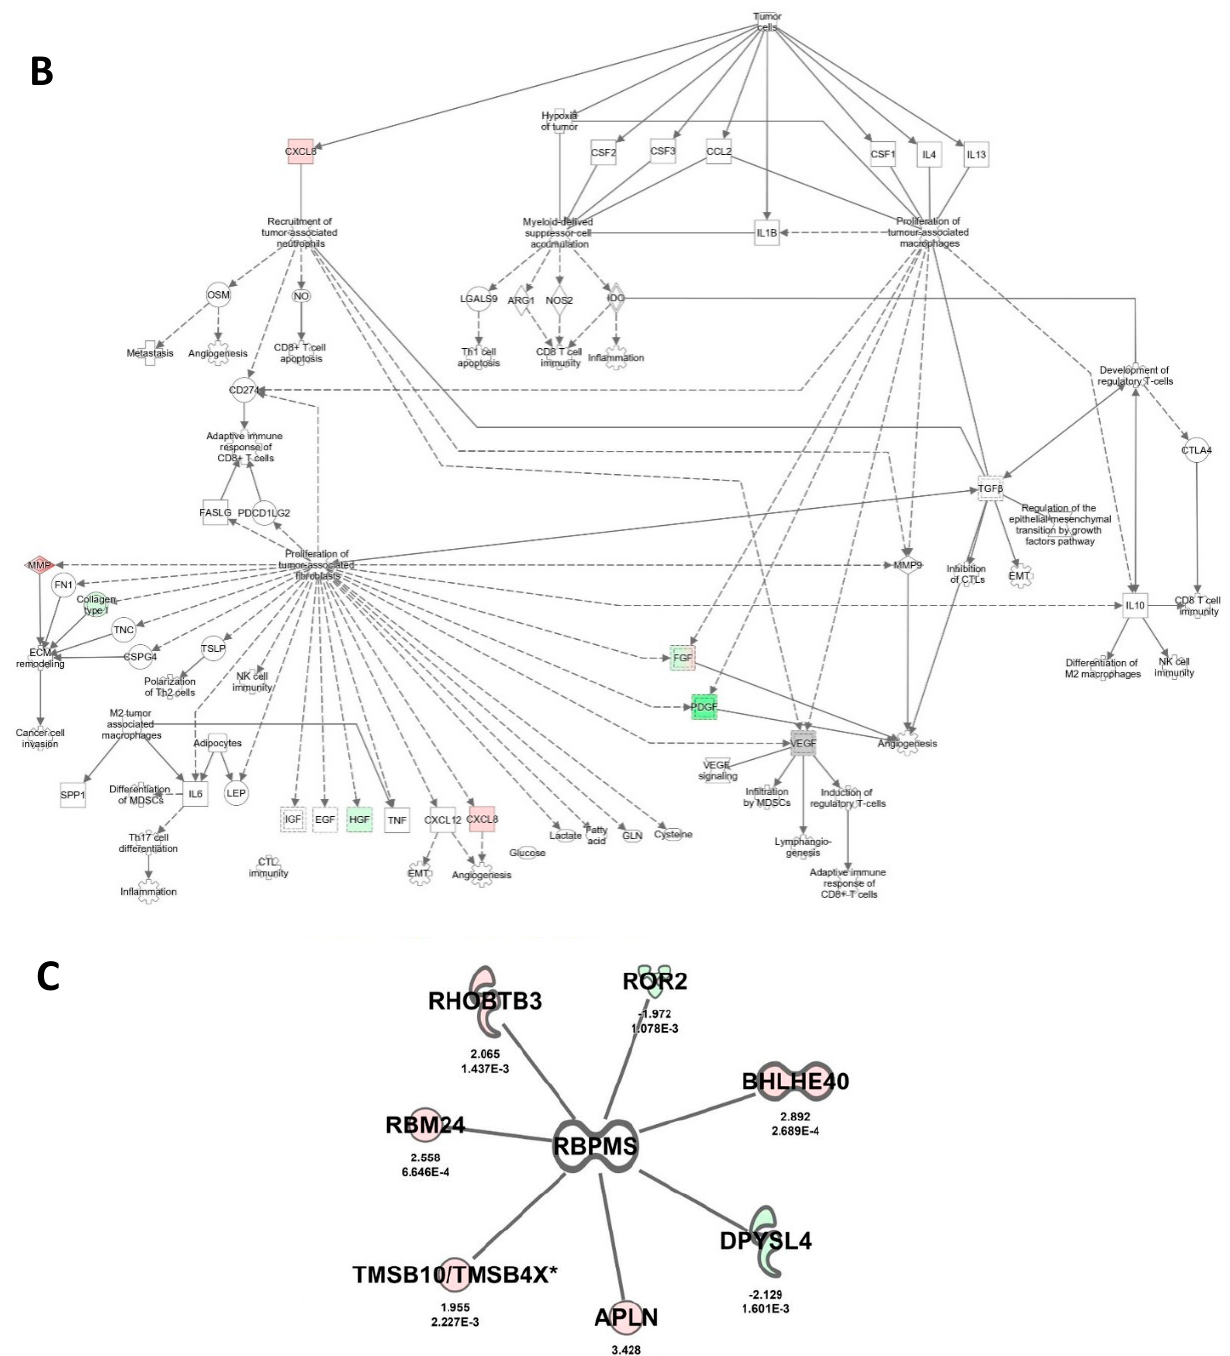
Figure 4. Ingenuity pathway analysis (IPA) of deregulated transcripts in SG2 and EV clones: ( A ) Interactions between the top five canonical pathways as found in the RNAseq studies. ( B ) A segment of the tumor microenvironment pathway. ( C ) A node showing seven of the identified transcripts directly interacting with RBPMS. Red color denotes upregulated RNA transcripts, and green denotes downregulated RNA transcripts following RBPMS knockdown.